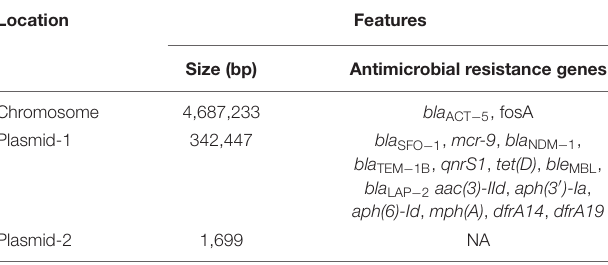
TABLE 3 | General features, antimicrobial resistance genes, and mobile genetic elements of plasmids p1575-1 and p1575-2.